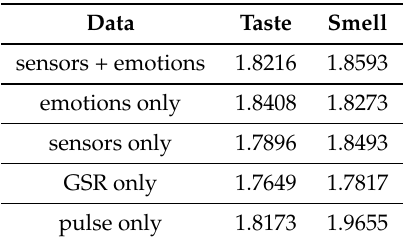
Table 1. Mean absolute error (MAE) for the regression model.